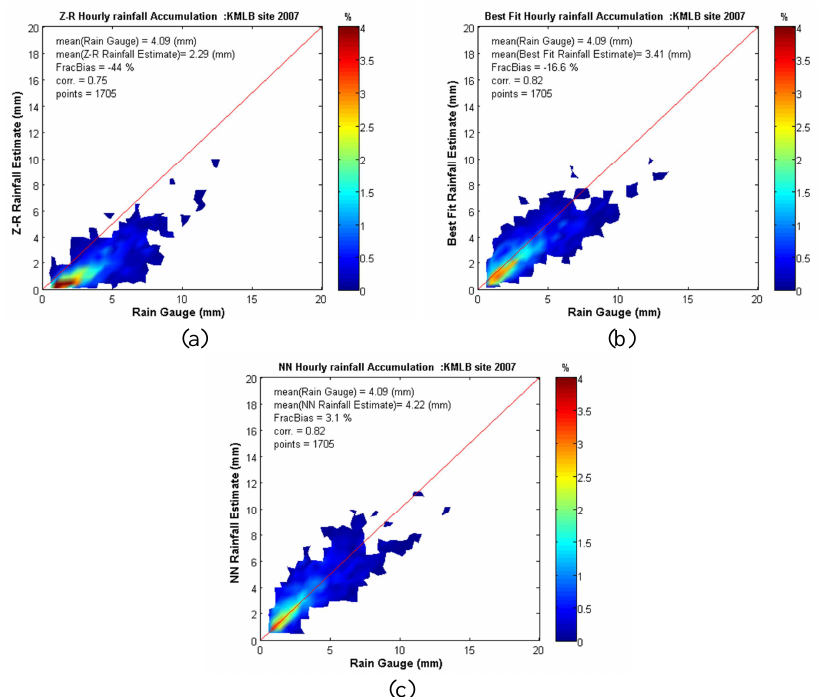
Fig. 7. Actual rain gauge vs. (a) Z – R estimate (b) best-fit estimate and (c) NN estimate. Data from year 2007 over KMLB. (Hourly rainfall